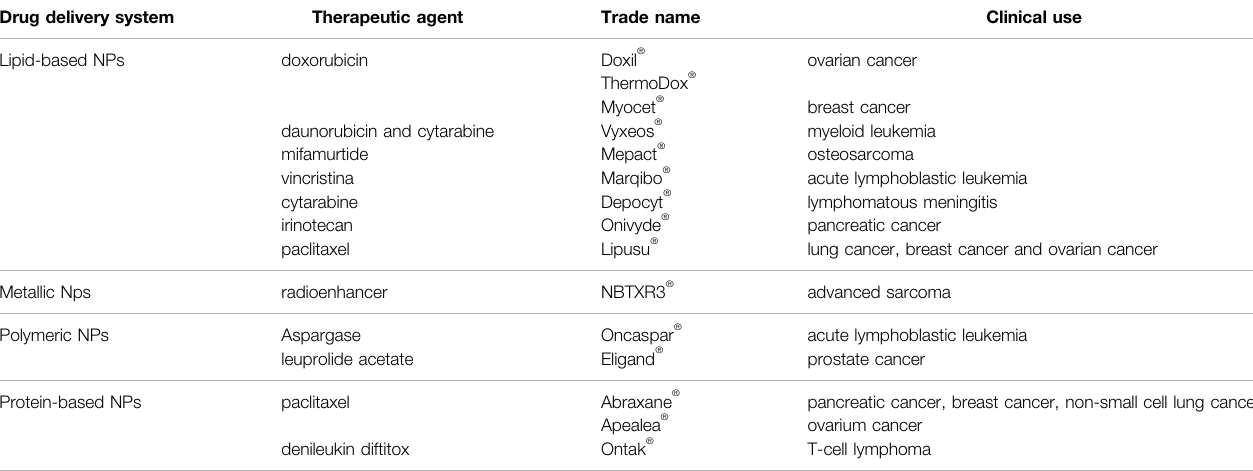
TABLE 2 | Type of anti-cancer nanomedicines on the